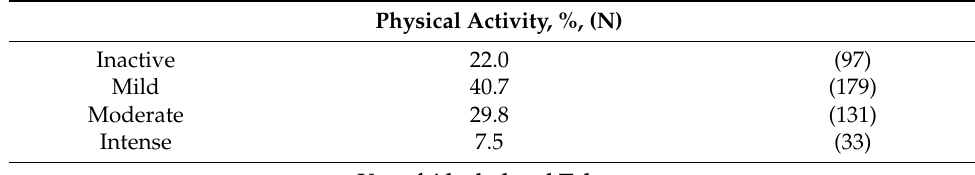
Table 3. Physical activity and smoking and drinking